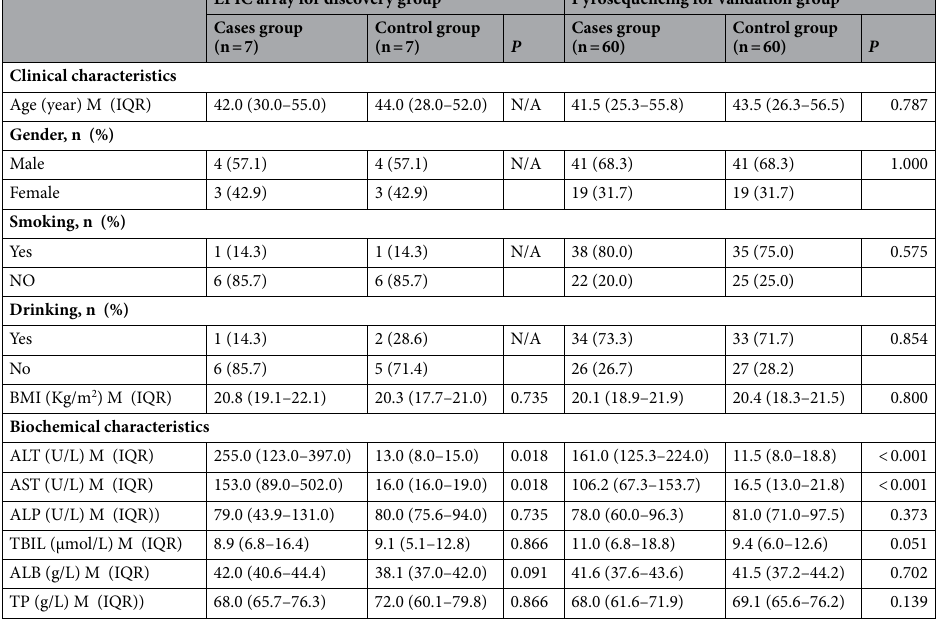
Table 1. Clinical and biochemical characteristics of